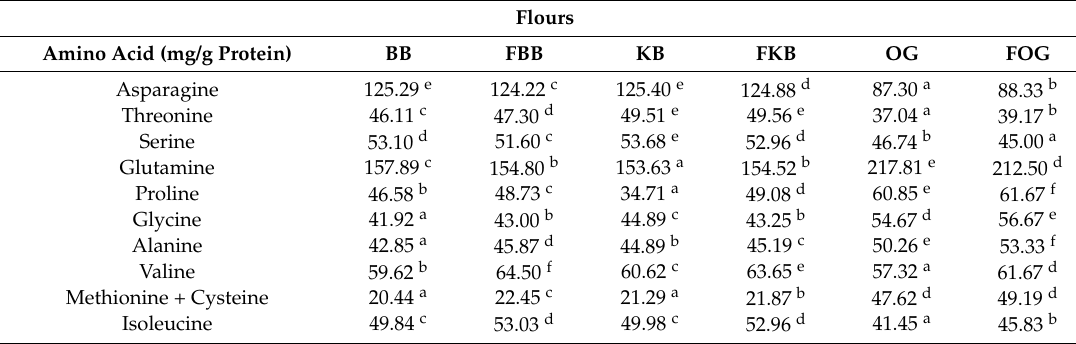
Table 4. Effect of Pleurotus ostreatus on the amino acid profile.